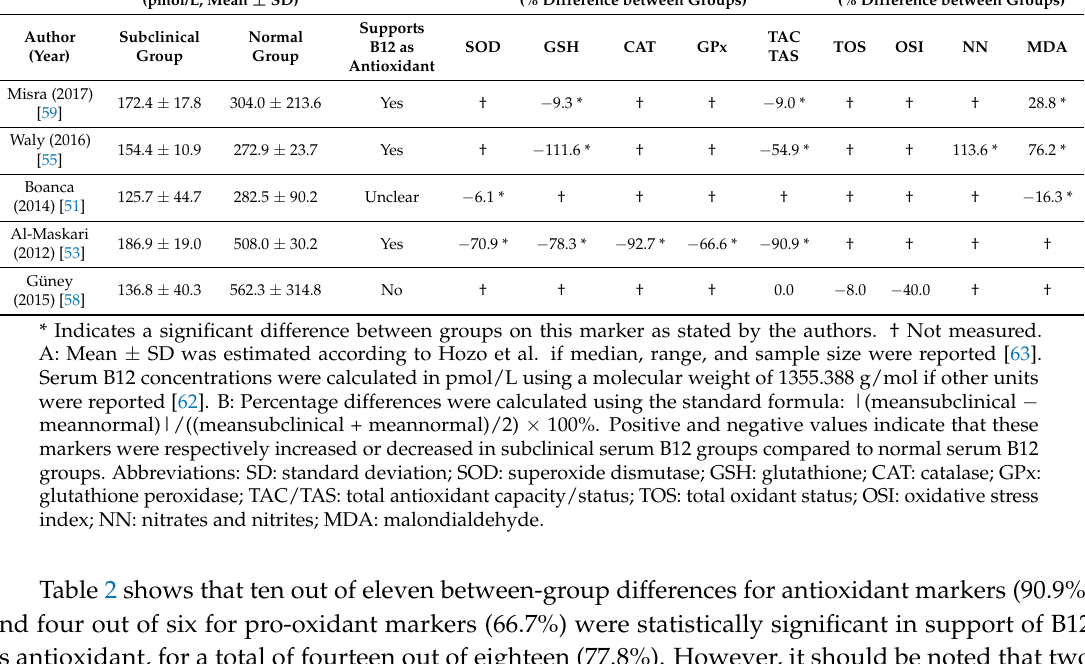
Table 2. Subclinical B12 deficiency in relation to oxidative stress; results from case-control studies.